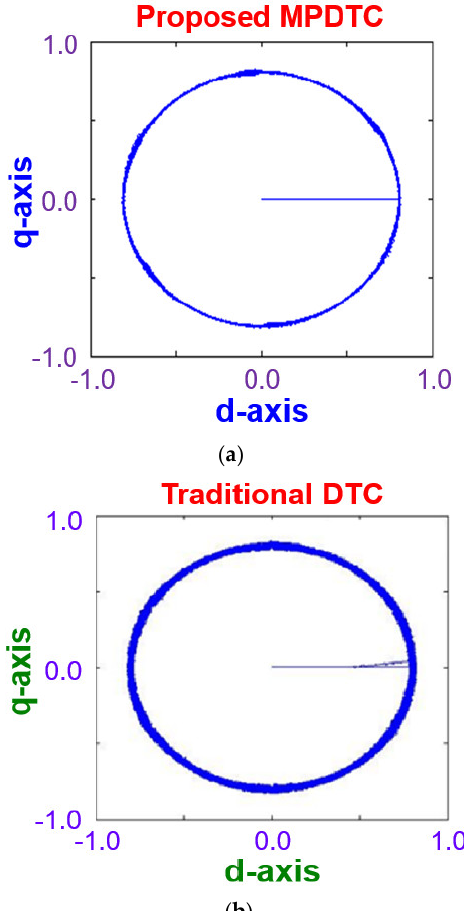
Figure 15. Simulated stator flux trajectory of ( a ) proposed MPDTC and ( b ) traditional DTC systems.